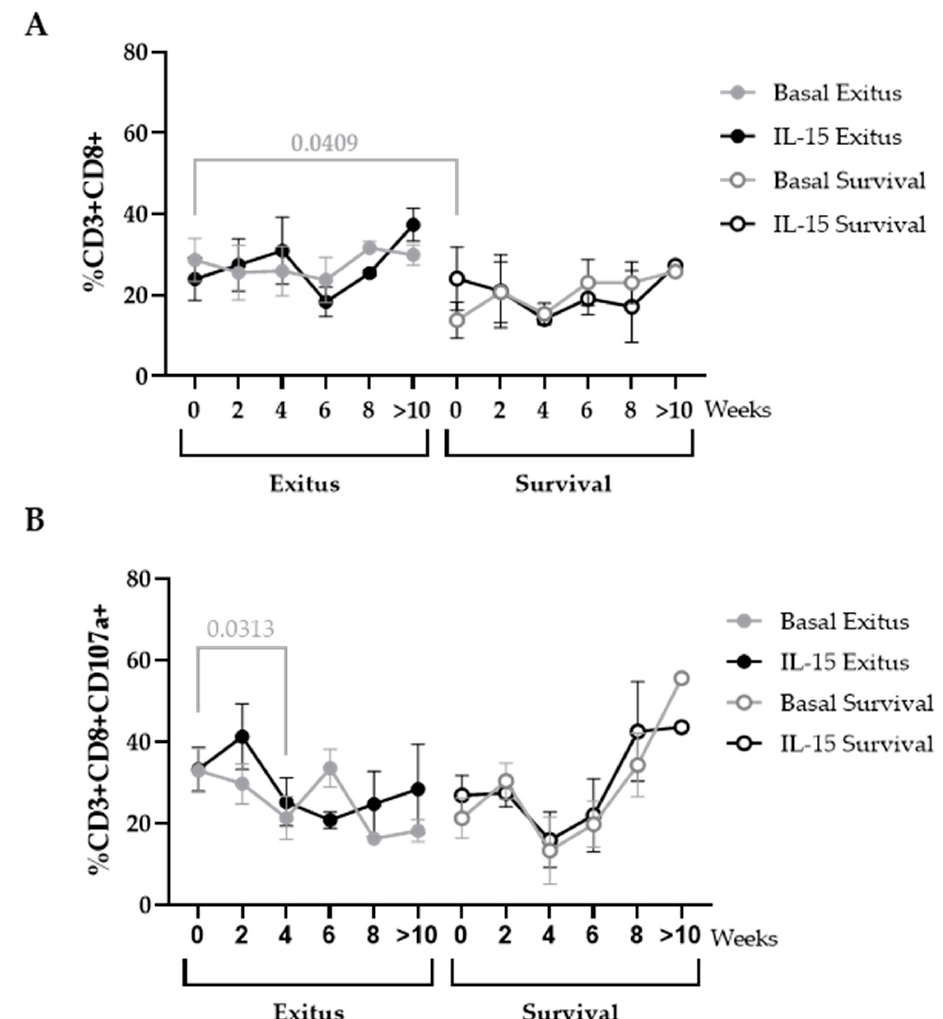
Figure 6. Levels of CD8+ T cells in PBMCs from individuals hospitalized with critical COVID-19. ( A ) Total levels of CD8+ T cells (CD3+CD8+) and ( B ) expression of the degranulation marker CD107a in these cells was evaluated in PBMCs in basal conditions (gray lines) or after treatment with IL-15 for 48 h (black lines) after co-culture (1:1) with Vero E6 cells infected with pseudotyped SARS-CoV-2 for 1 h. Each dot corresponds to the mean of data, and vertical lines represent SEM. Statistical significance between groups was calculated using Mann–Whitney U-test, and within groups, Wilcoxon U-test was